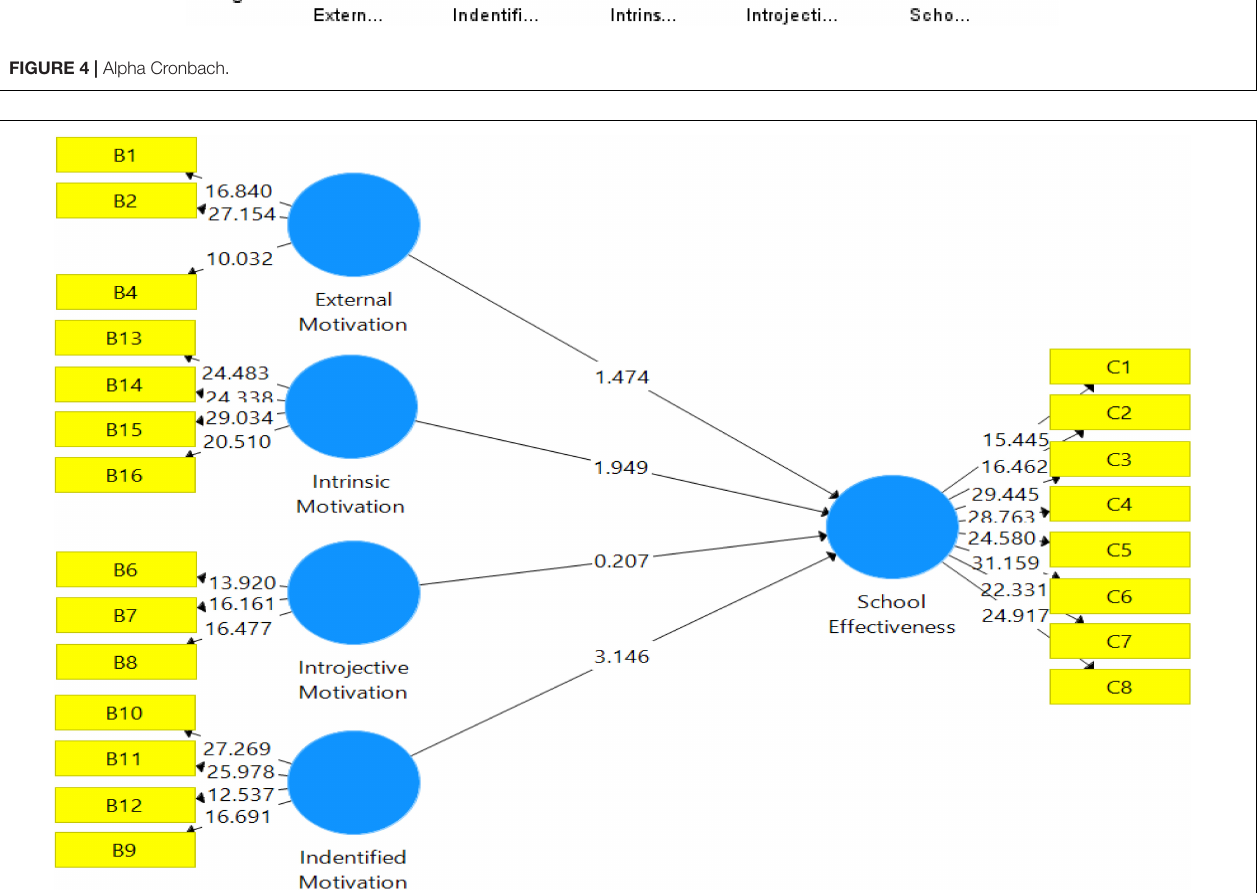
FIGURE 5 | Analysis of the model